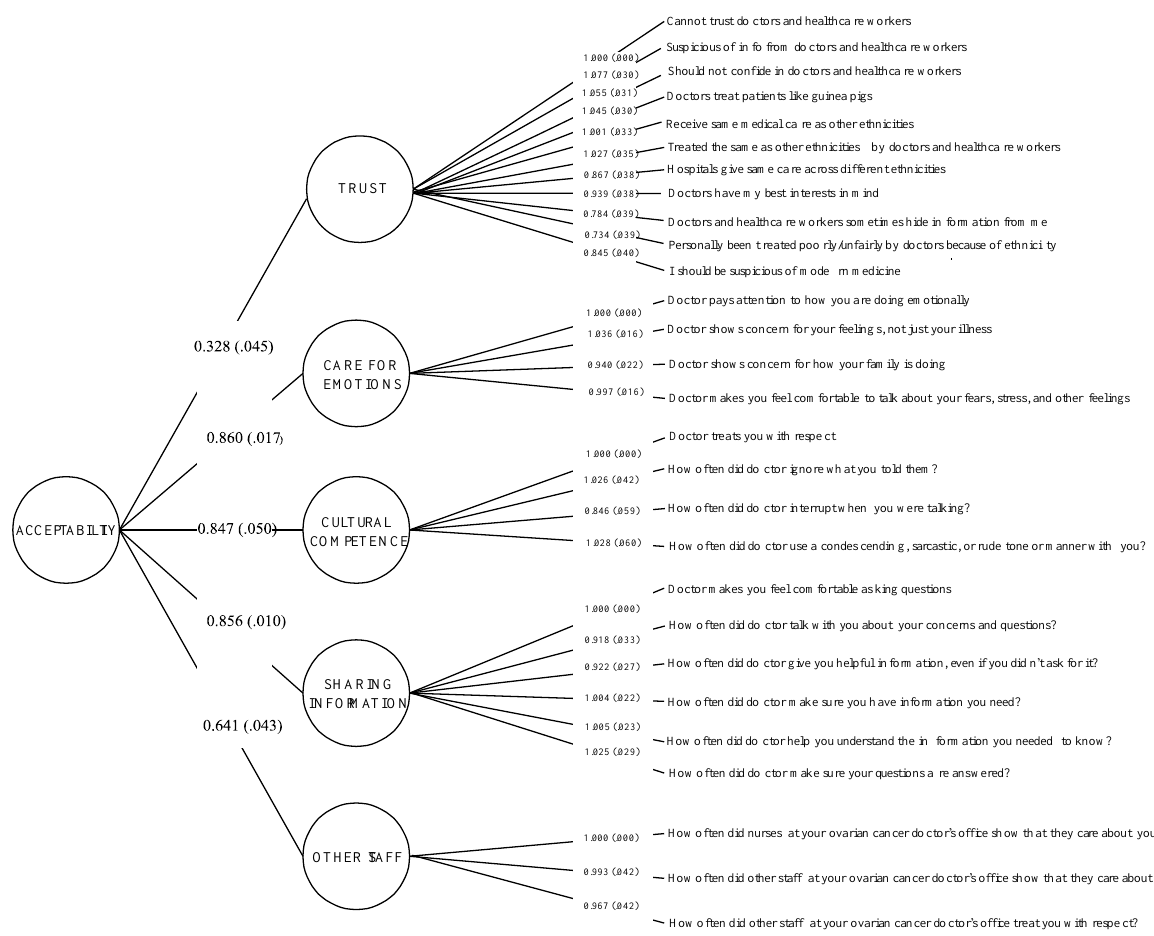
Figure 3. A Five-Factor Higher-Order Model of Acceptability Dimension.